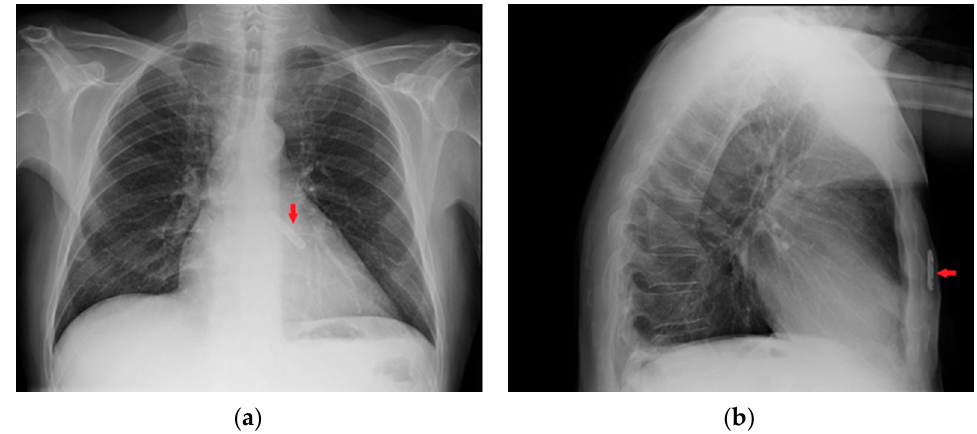
Figure 13. Images of a subcutaneous implantable loop recorder on PA ( a ) and LL ( b ) views of a CXR